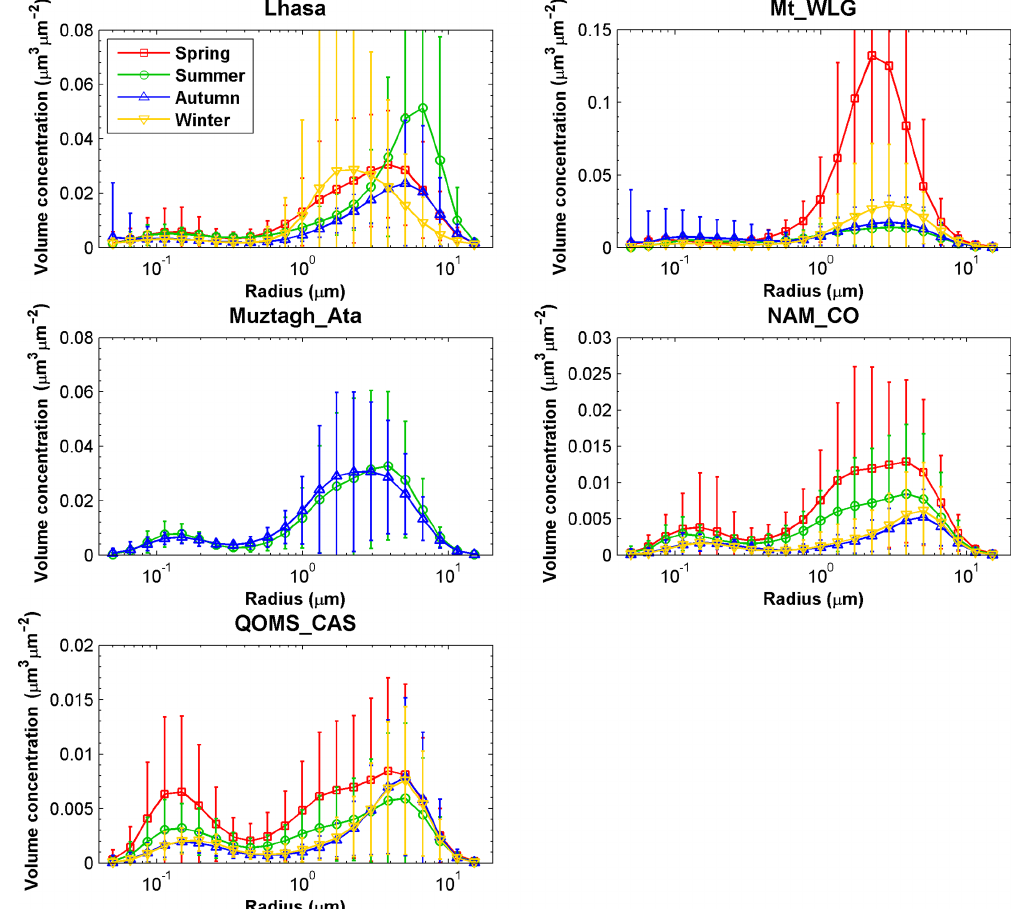
Figure 3. Seasonal variation in aerosol size distribution at the five sites located in the Tibetan